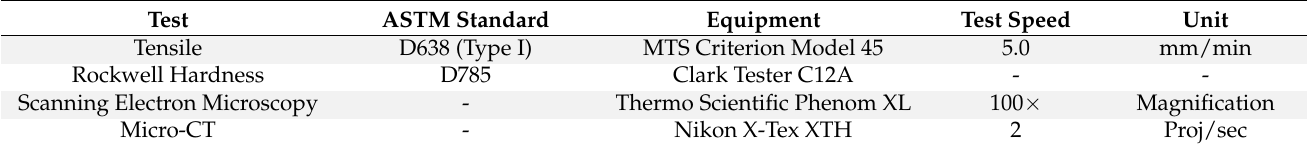
Figure 3. X-ray micro-CT setup and detailed scanning parameters . The scan was performed on the CT scan microscope with the scanning point-to-point resolution set to 2.5 µm at an exposure time of 500 ms with a total of 3016 tiff images created per sample scan. The acquired microscopy data were transferred and post-pro- cessed using commercial software (Dragonfly ORS, Adelaide, South Australia, Australia). The automatic features of the software were used to determine the optimum center of rotation, with all generated slices combined to develop the volumetric image in the recon- struction phase. Characterization noise generated with the volumetric imaging was re- duced using Gaussian filters, which, in the case of this investigation, resulted in minimal data loss from the sample materials’ homogeneity. The generated tiff files were incorpo- rated into the software with voxel analysis to determine volumetric porosity.